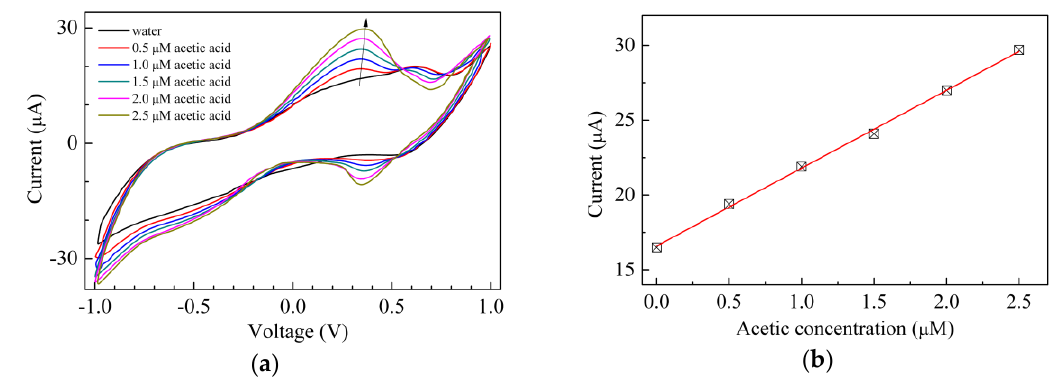
Figure 9. ( a ) Current-voltage loop of the Au/chitosan:CuOx/chitosan/Au cell, measured in pure water, and in the presence of acetic acid at different concentrations; ( b ) Intensity of the forward current peak intensities of Figure 9a, plotted against the acetic acid concentration.